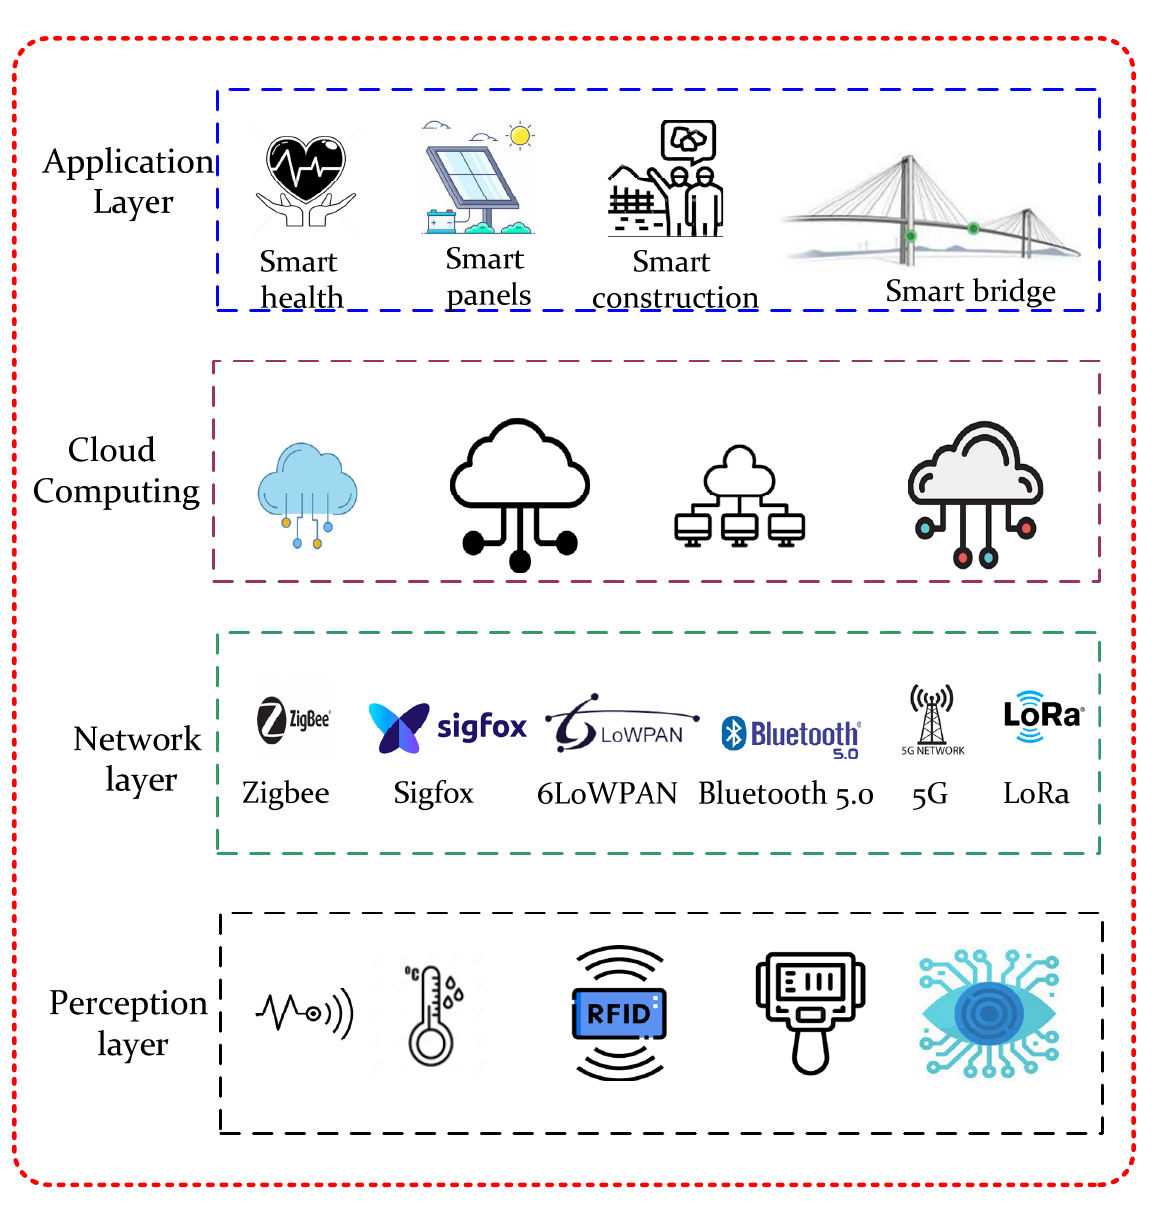
Figure 5. IoT architecture.